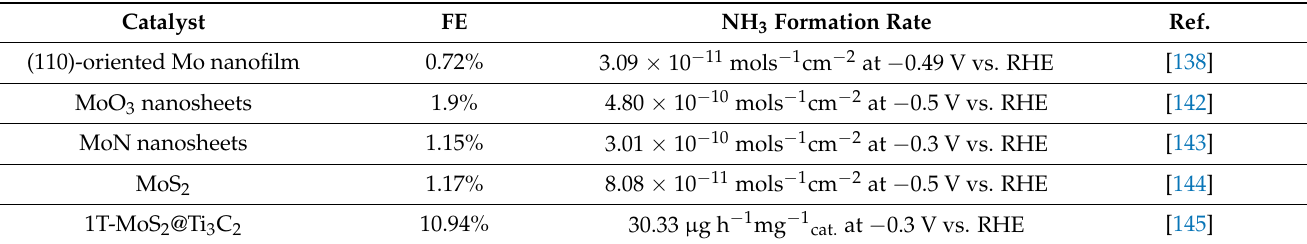
Table 2. Faradaic efficiencies, NH 3 formation rates of different Mo-based catalysts. Catalyst FE NH 3 Formation Rate Ref. (110)-oriented Mo